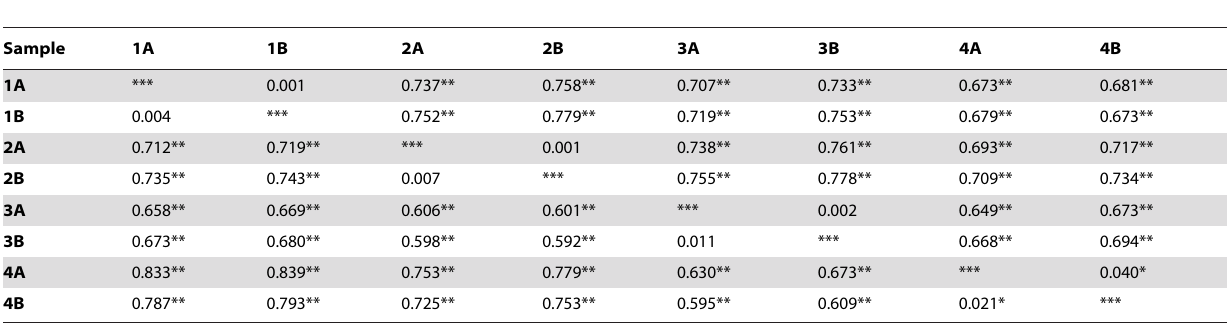
Table 4. Pairwise F ST estimates (above diagonal) and genetic distances (D CE , below diagonal) between samples, labeled as in Table 3.